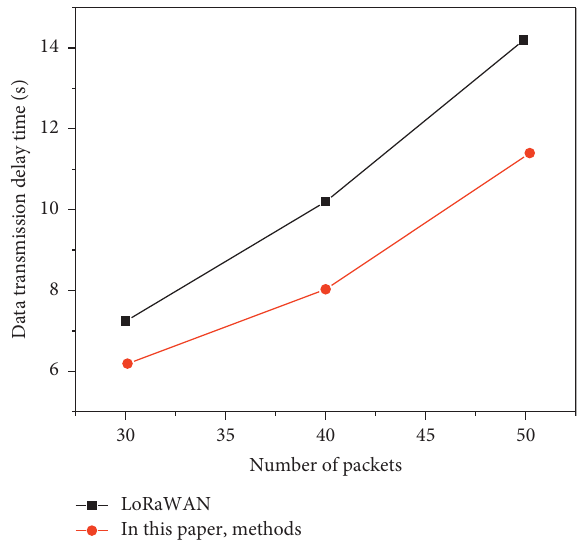
Figure 4: Comparison of data rate level DR3.